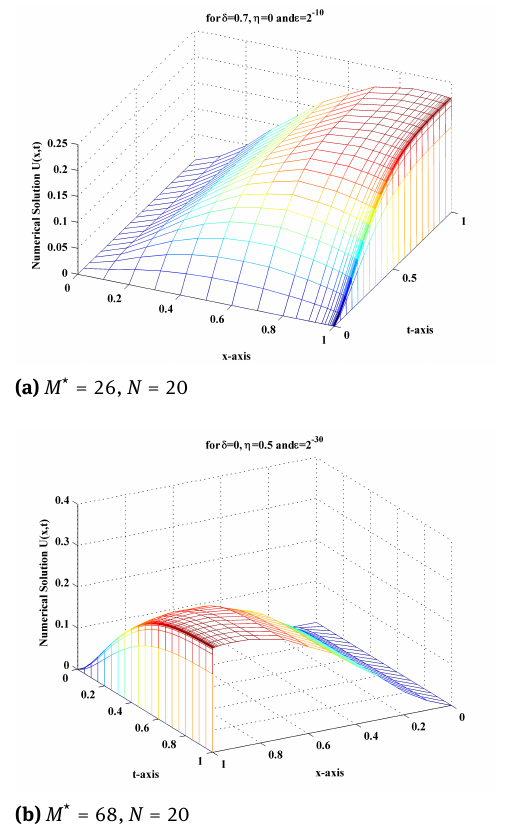
Fig. 6: Surface plot of example 5.2, using adaptive mesh for differ- ent values of ϵ , δ and η .